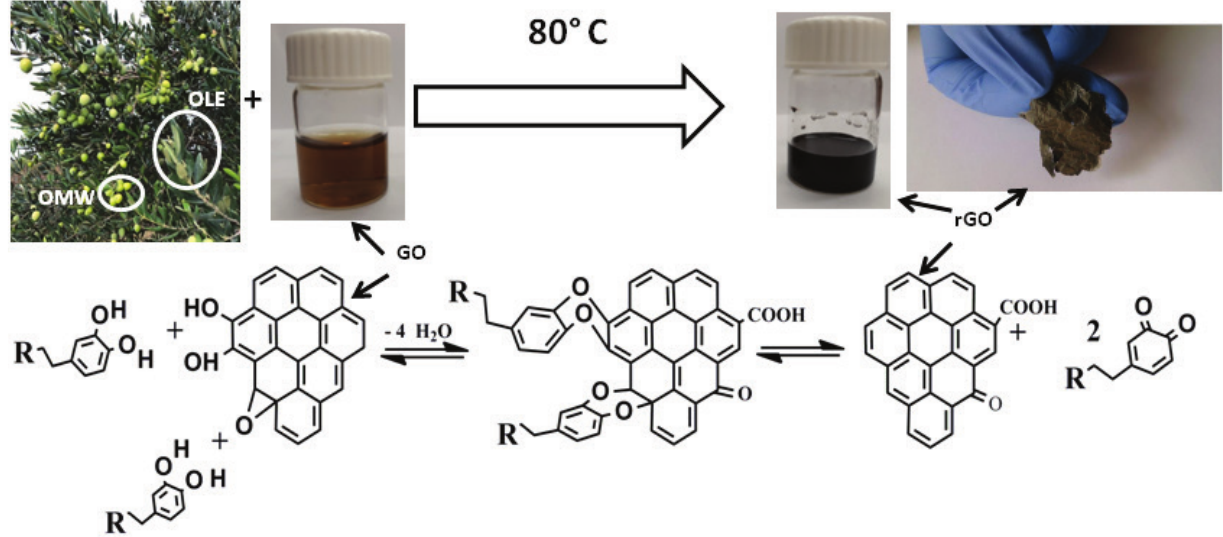
Fig. 5 – Schematic representation of the reduction process, reactants, and obtained